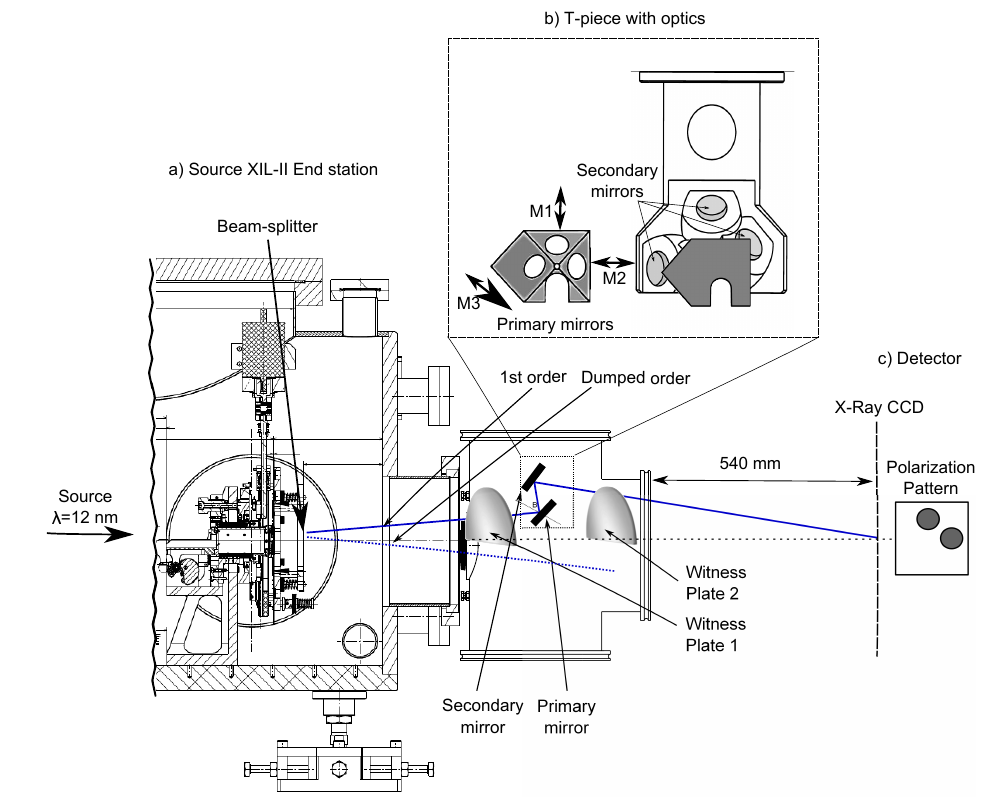
Figure 1. Sketch of the Stokesmeter. ( a ) The X-ray Interference Lithography (XIL-II) end station holds the beam-splitter. ( b ) The main body of the Stokesmeter is the mount for the optical elements, i.e. , the primary and the secondary polarizer mirrors. The primary mirrors are inclined at the Brewster angle along the vertical (M1), horizontal (M2) and 45 ◦ (M3) axis. The radiation is monitored at three different positions, i.e. , before the optics (Witness Plate 1), after the optics (Witness Plate 2) and at the detector ( c